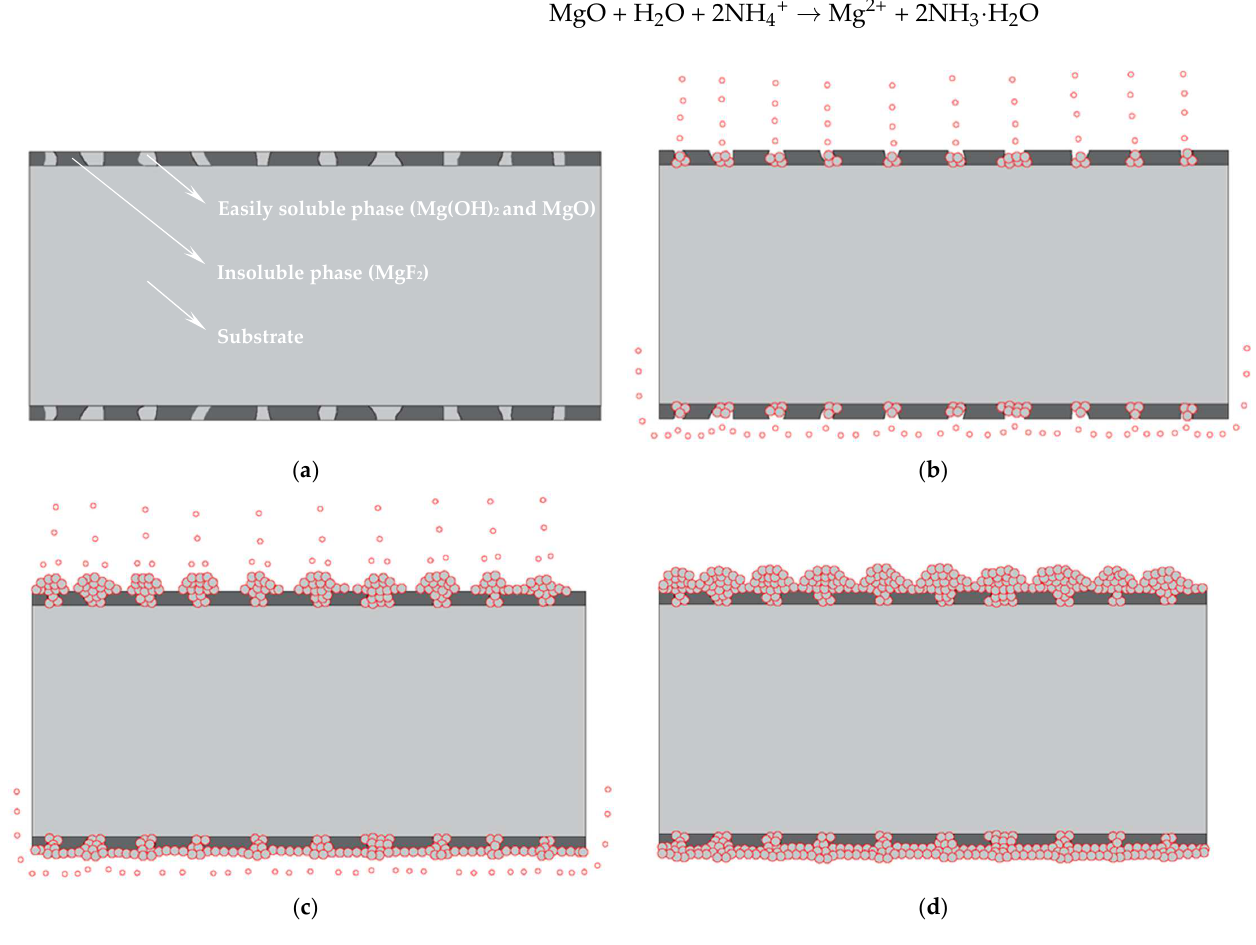
Figure 5. Schematic diagram of the process of depositing Ni–P on the surface of Mg–Li alloy: ( a ) the initial state, ( b ) dissolution of easily soluble phase and the replacement reaction, ( c ) the autocatalytic reaction, and ( d ) deposition completion.